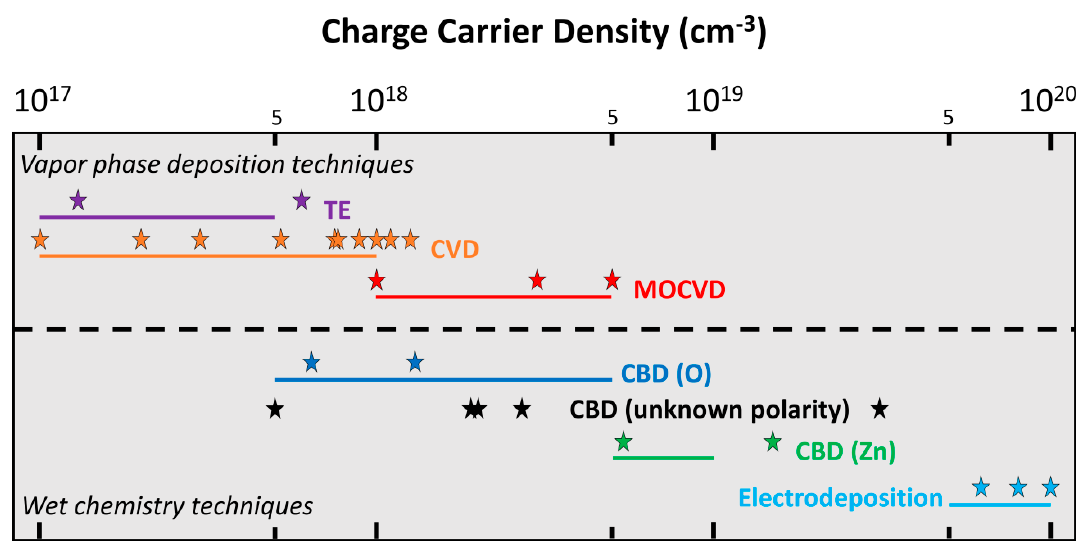
Figure 3. Schematic diagram summarizing experimental data for charge carrier density in ZnO NWs grown by TE [29,40], CVD [28,44–50], MOCVD [31–33], CBD (O) [36], CBD (unknown polarity) [34,37,43], CBD (Zn) [36], and electrodeposition [38,39,41]. A logarithmic scale is used for doping level. The coloured solid stars represent the experimental data point reported in the literature for each growth method, as an average value [28,29,33,34,38–41,44,49,50] or an interval of minimum and maximum values [31,32,36,37,43,45–48]. The coloured solid lines represent the deduced range of charge carrier density used in the numerical simulation for each growth method.